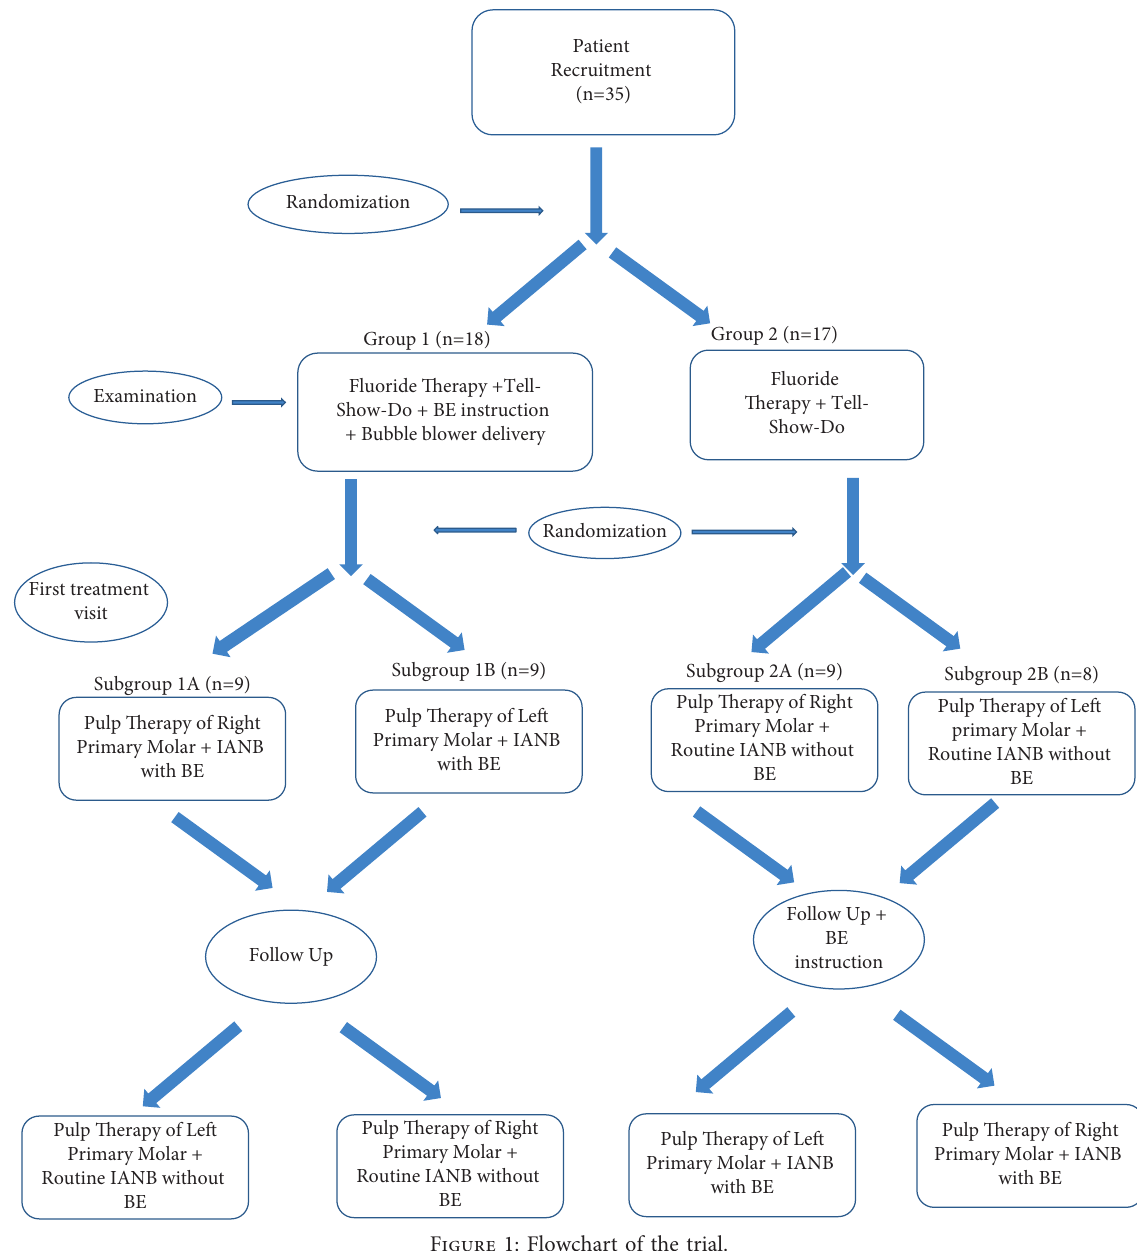
Figure 1: Flowchart of the